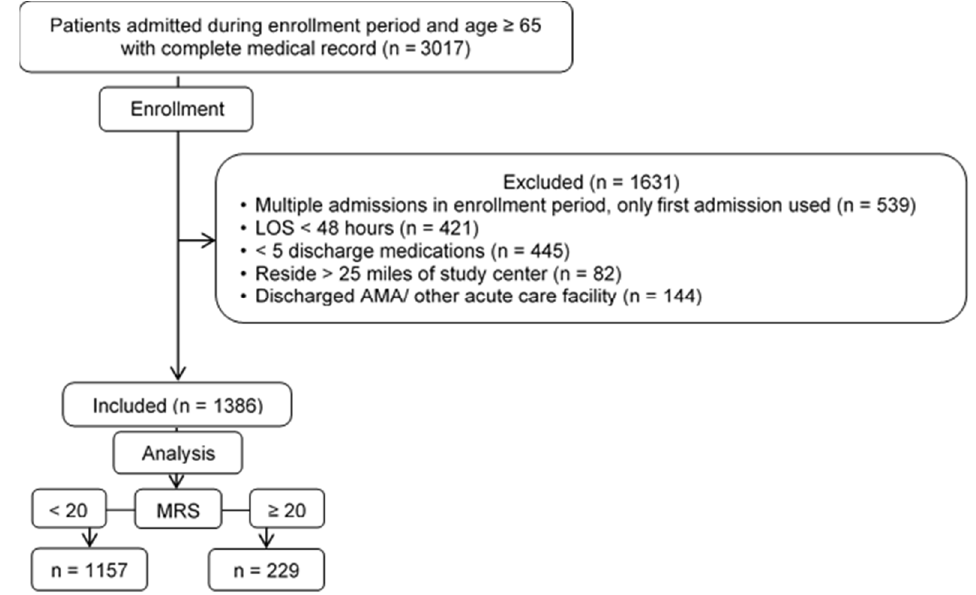
Figure 1. Patient Selection Process. LOS = length of stay. Table 1. Clinical characteristics of all patients and